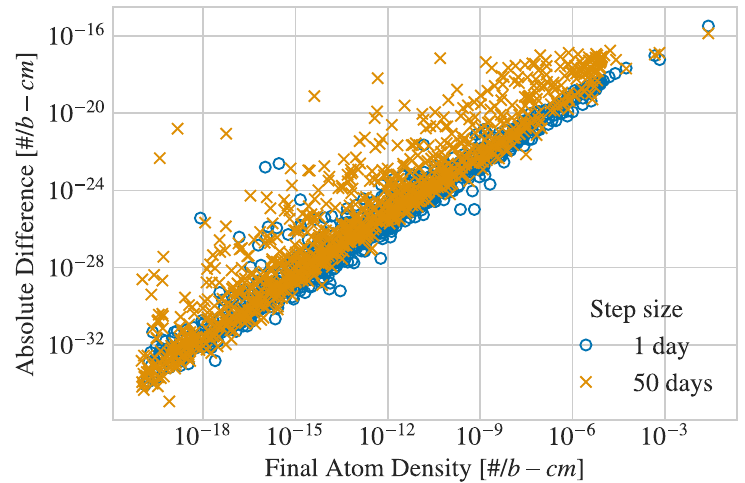
Figure 1: Absolute difference in EOS compositions with external IPF solver compared to Serpent internal